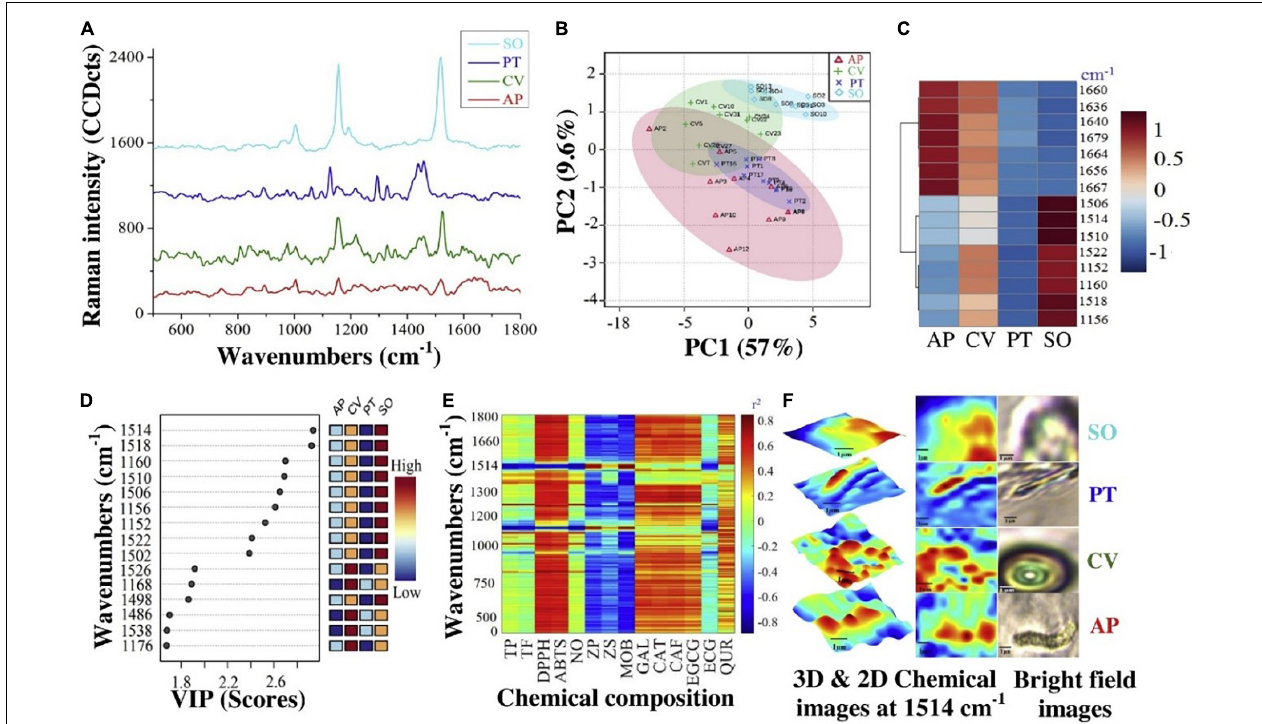
FIGURE 7 | Single-cell Raman micro spectrometry chemical composition of A. platensis (AP), C. vulgaris (CV), P. tricornutum (PT), and S. obliquus (SO). (A) Full spectra, (B) PCA, (C) clustering heatmap, (D) VIP, (E) correlation (r 2 ) summarization, and (F) 3D & 2D chemical images at 1514 cm − 1 (2) (Copyright permission: 5179160871508).